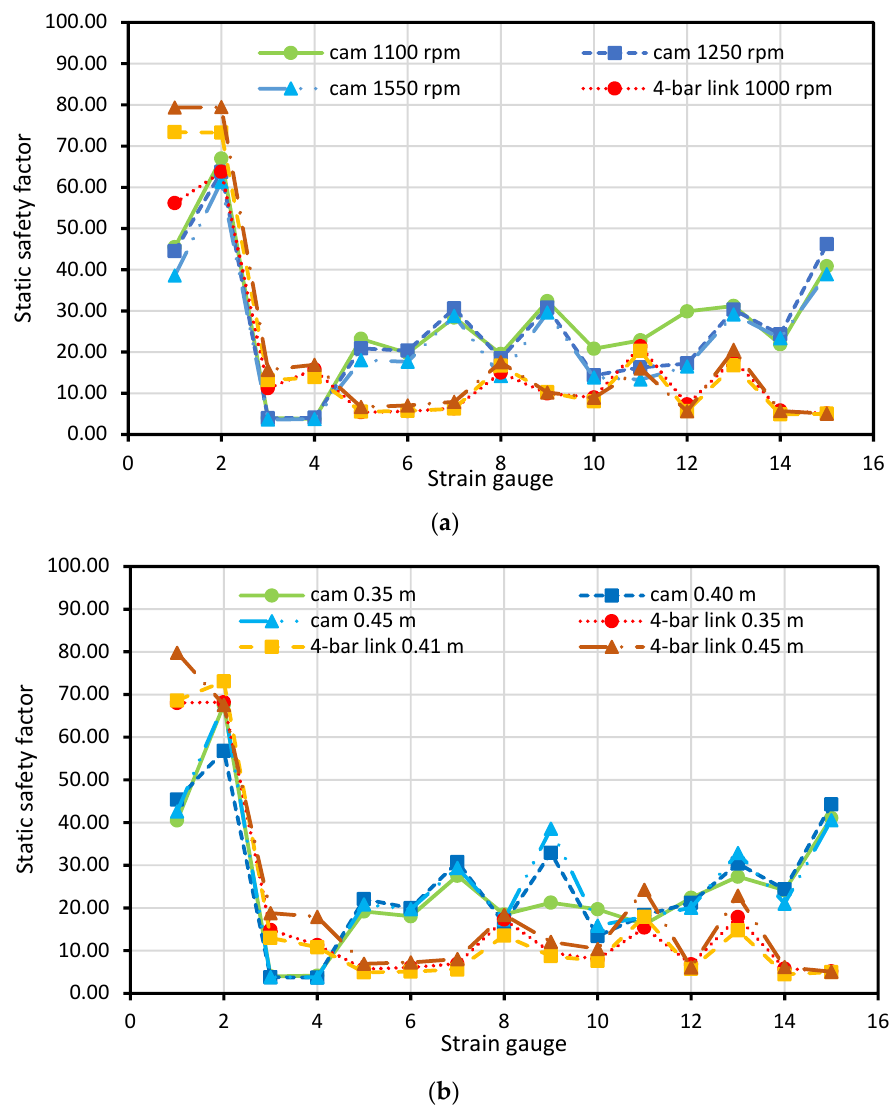
Figure 15. Comparison of static safety factor between cam and four-bar-link types on every strain gauge location in the transplanting device according to working conditions: ( a ) engine speed and ( b ) planting distance.